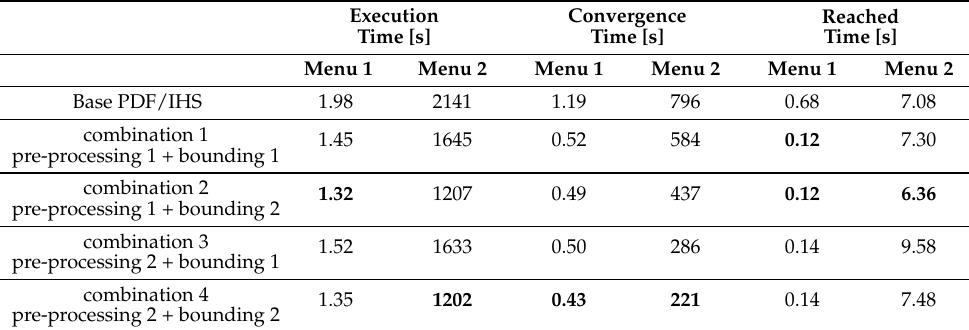
Table 4. Execution time, convergence time, and reached time of the